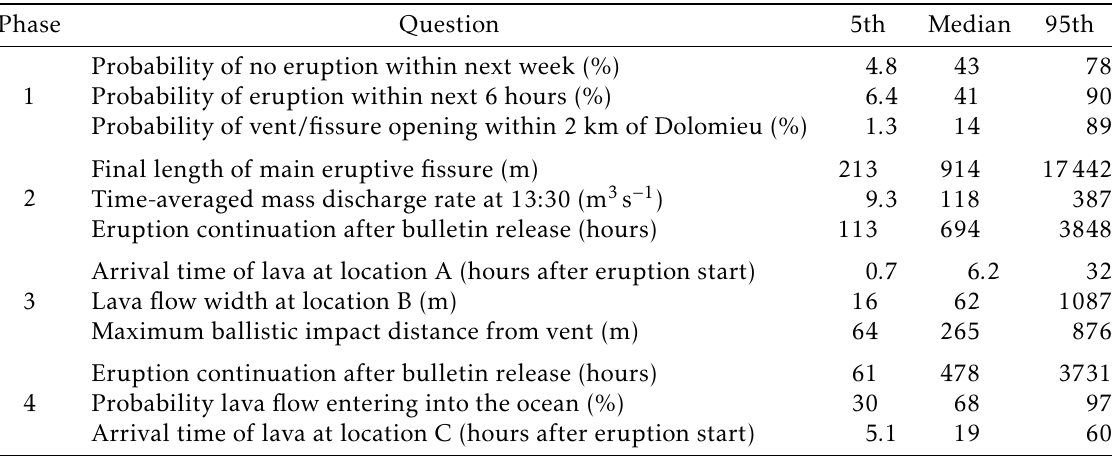
Table 2: Percentile values for the probability density functions of the CM of Figure 5. In contrast to Figure 5, values of questions 1 and 3 from Phase 2 and question 1 from Phase 4 have been reported here on a linear